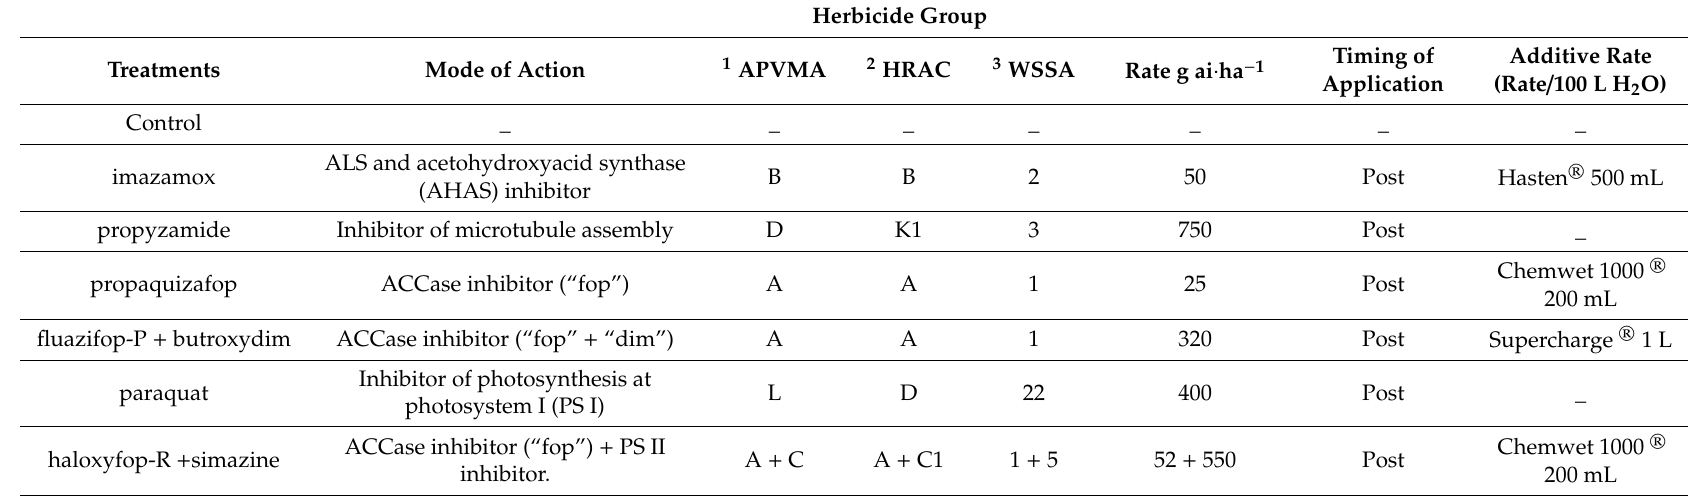
Table 3. Herbicide treatments and additives applied during the 2017 herbicide